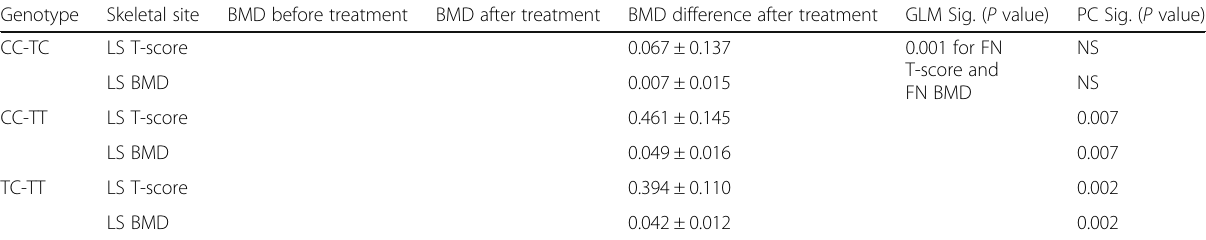
Table 7 BMD changes after raloxifene therapy in relation to the rs9340799 and rs2234693 genotypes (Continued)